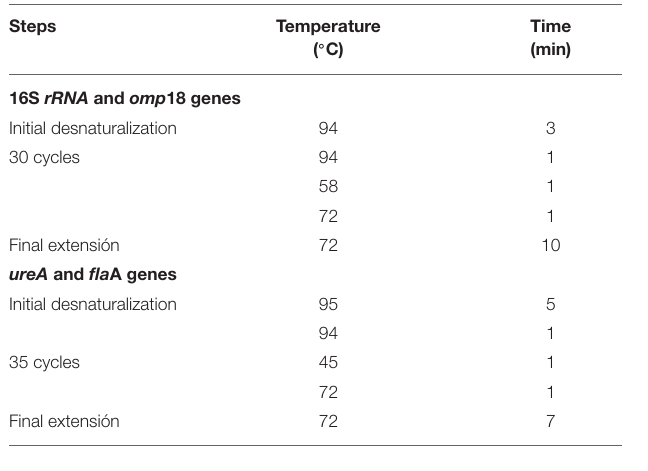
TABLE 2 | Protocols of PCR amplification for Helicobacter pylori genes.